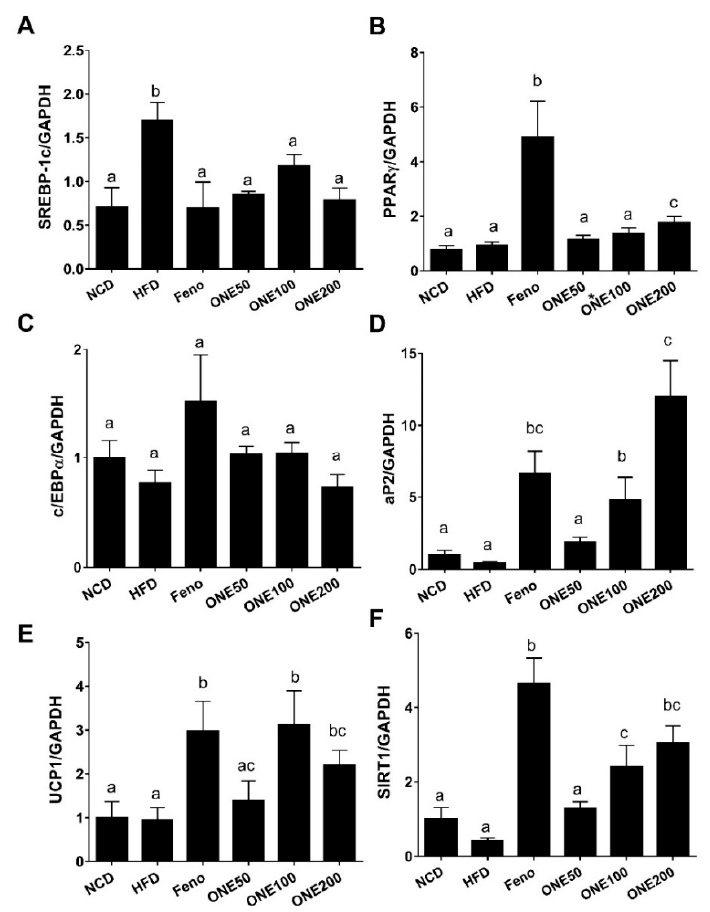
Figure 6. ONE suppresses expression of lipogenic and adipogenic genes but upregulates the expression of browning genes. After four weeks of ONE administration, mouse WATs were collected. Expression levels of lipogenic gene (( A ) SREBP-1c), adipogenic genes (( B ) PPAR γ , ( C ) CCAAT / enhancer-binding protein α (c / EBP α ) and ( D ) aP2), and browning genes (( E ) uncoupling protein 1 (UCP1), ( F ) sirtuin 1 (SIRT1)) were measured using qRT-PCR. Results are presented as mean ± SEM ( n = 7). Di ff erent letters indicate statistical significance among treatment groups.